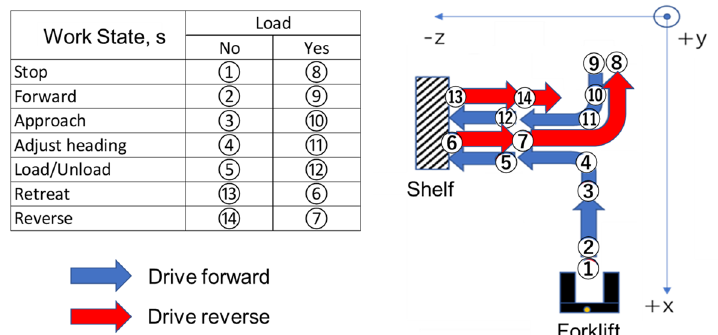
Figure 6. A typical forklift operation consists of a sequence of basic work states, where a comple cycle consists of 14